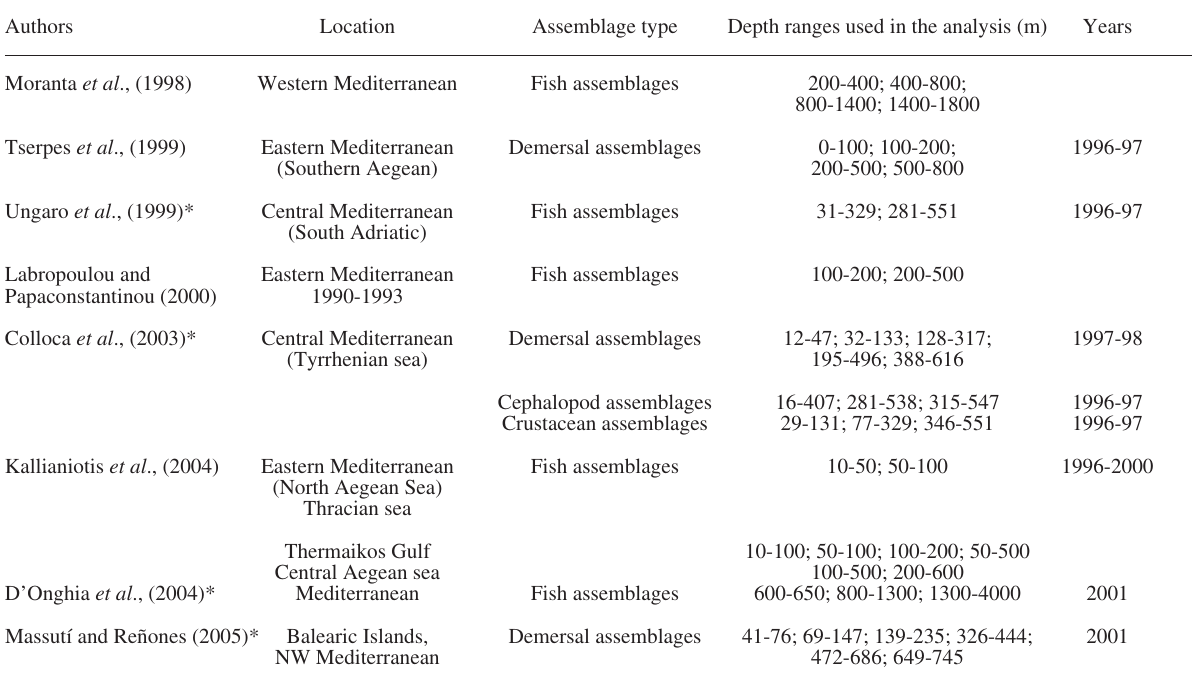
Table 4. – A summary of studies on deep water assemblages in the Mediterranean. The studies marked with an asterix have used an a posteriori approach to determine the assemblage structure.